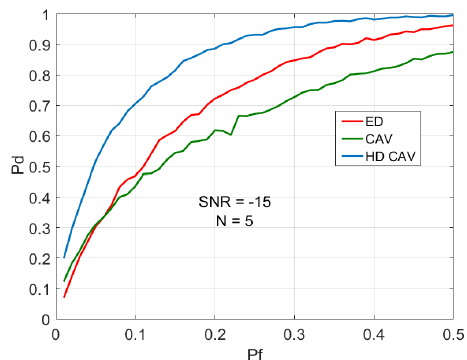
Figure 10. The ROC curves for HD CAV (with uncertainty of spectral density of noise power estimation influence)